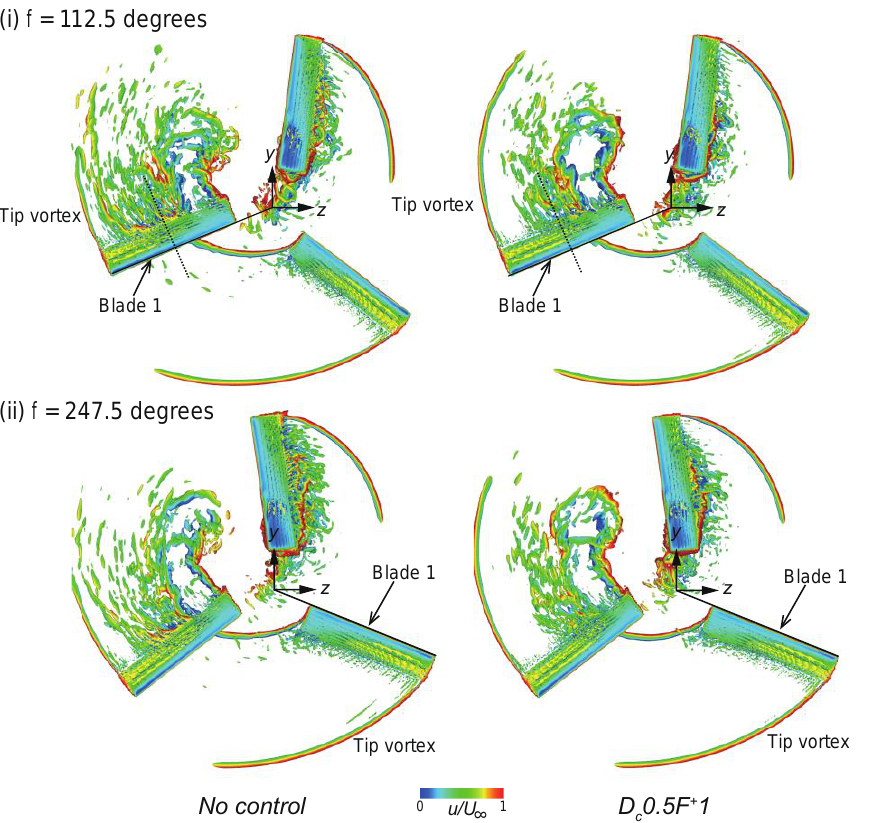
Figure 7. Phase-averaged flow structures around the blades. Isosurface is Q = 200.